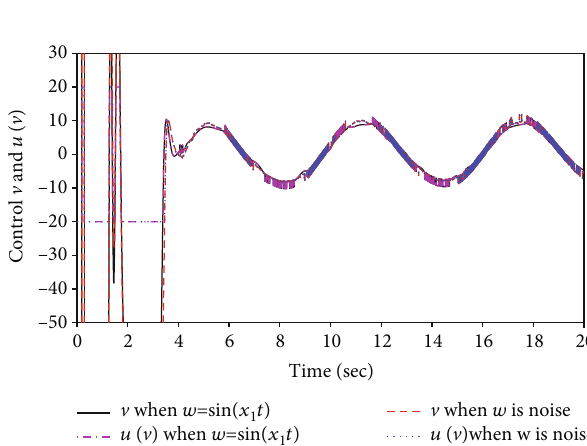
Figure 5: Tracking performance.